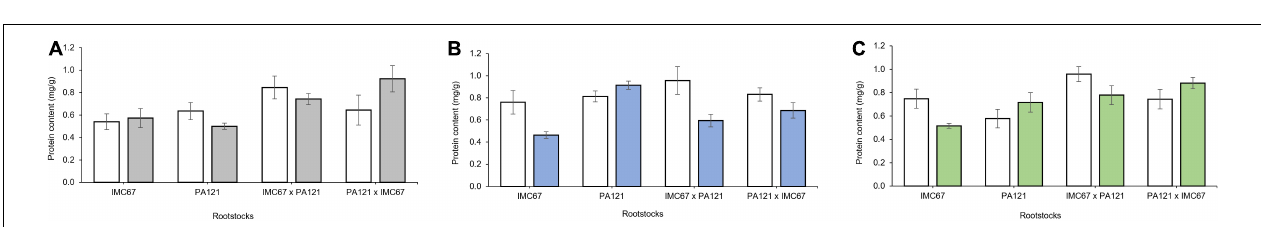
FIGURE 11 | Electrolyte leakage in four ungrafted seedling families subjected to two different concentrations of Cd in soil under greenhouse conditions 5 months after Cd addition. White bars represent ungrafted seedling families grown in soil without the addition of Cd (0.43 mg kg − 1 ). Gray bars represent ungrafted seedling families grown in Cd-spiked soil (7.49 mg kg − 1 ). Data are mean values ± SE ( n = 8).